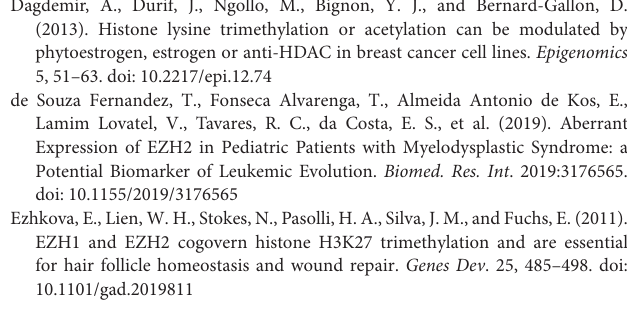
Supplementary Figure 1 | Inhibitory effect of EZH2 inhibitor and EHMT2 inhibitor on histone methylation. SKM-1 cells co-transfected with si-EZH1, pcDNA3.1-EZH2, and pcDNA3.1-EHMT2 were used as the control group. Cells in logarithmic growth phase were seeded into the 96-well plates (1 × 10 5